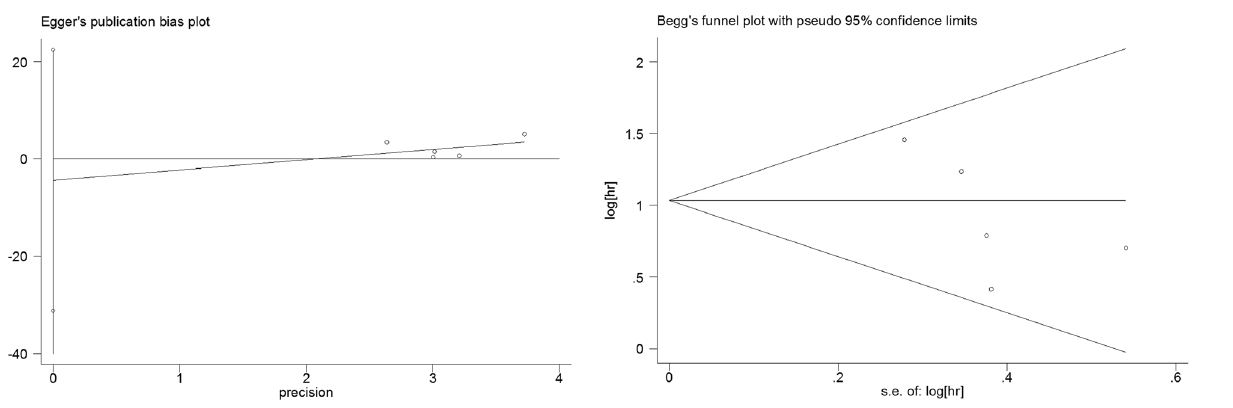
Figure 7: Begg ’ s funnel plots for evaluating publication bias